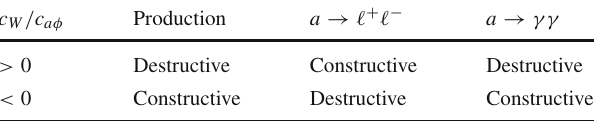
Table 1 ALP-mediated rare meson decays: interference pattern between c a (cid:7) and c W in ALP production and decay as a function of c W / c a φ sign, by assuming c B = c W . The a → γγ column assumes m a < m π , see text for